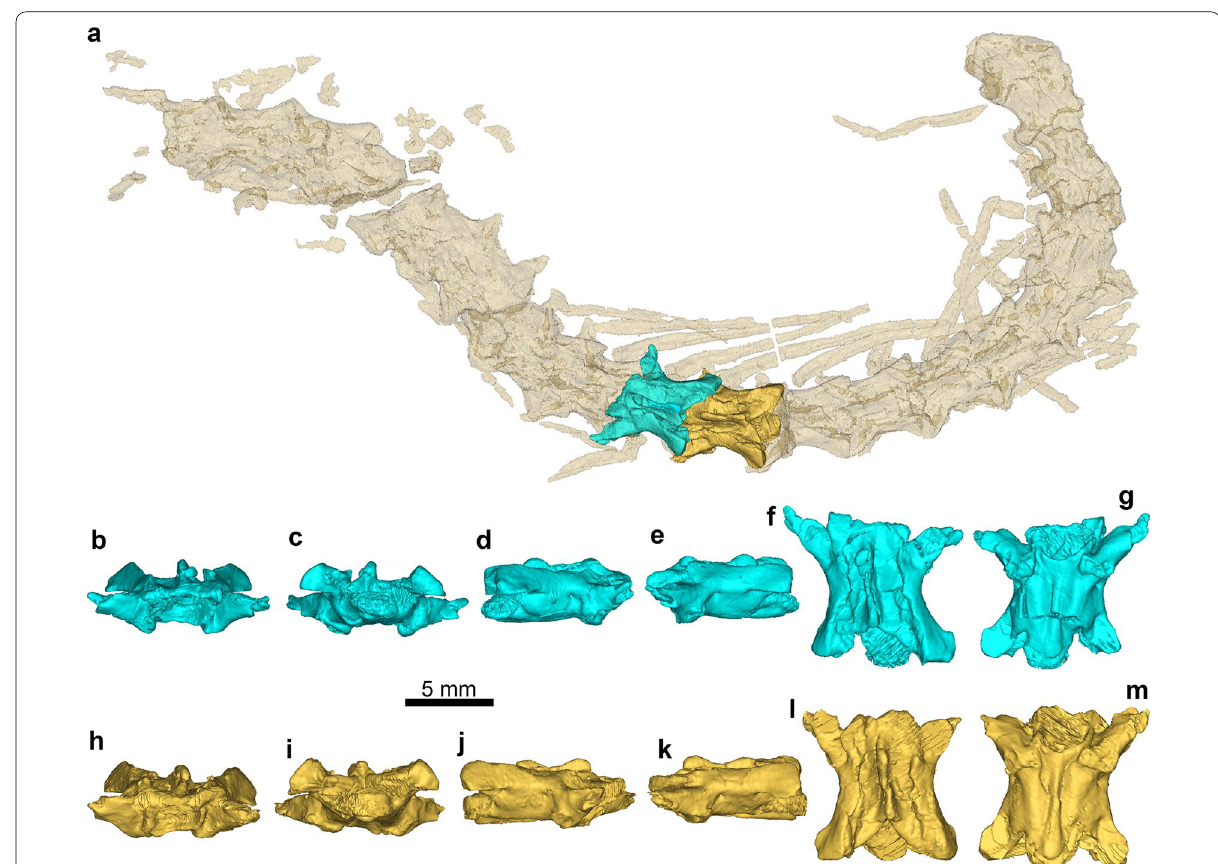
Fig. 3 Colubriformes indet. (PIMUZ A/III 191) from the middle Miocene of Käpfnach, Switzerland. a 3D model of the skeleton indicating the position of the two segmented vertebrae; b–g 3D models of the first vertebra in anterior ( b ), posterior ( c ), right lateral ( d ), left lateral ( e ), dorsal ( f ), and ventral ( g ) views; h–m 3D models of the second vertebra in anterior ( h ), posterior ( i ), right lateral ( j ), left lateral ( k ), dorsal ( l ), and ventral ( m )